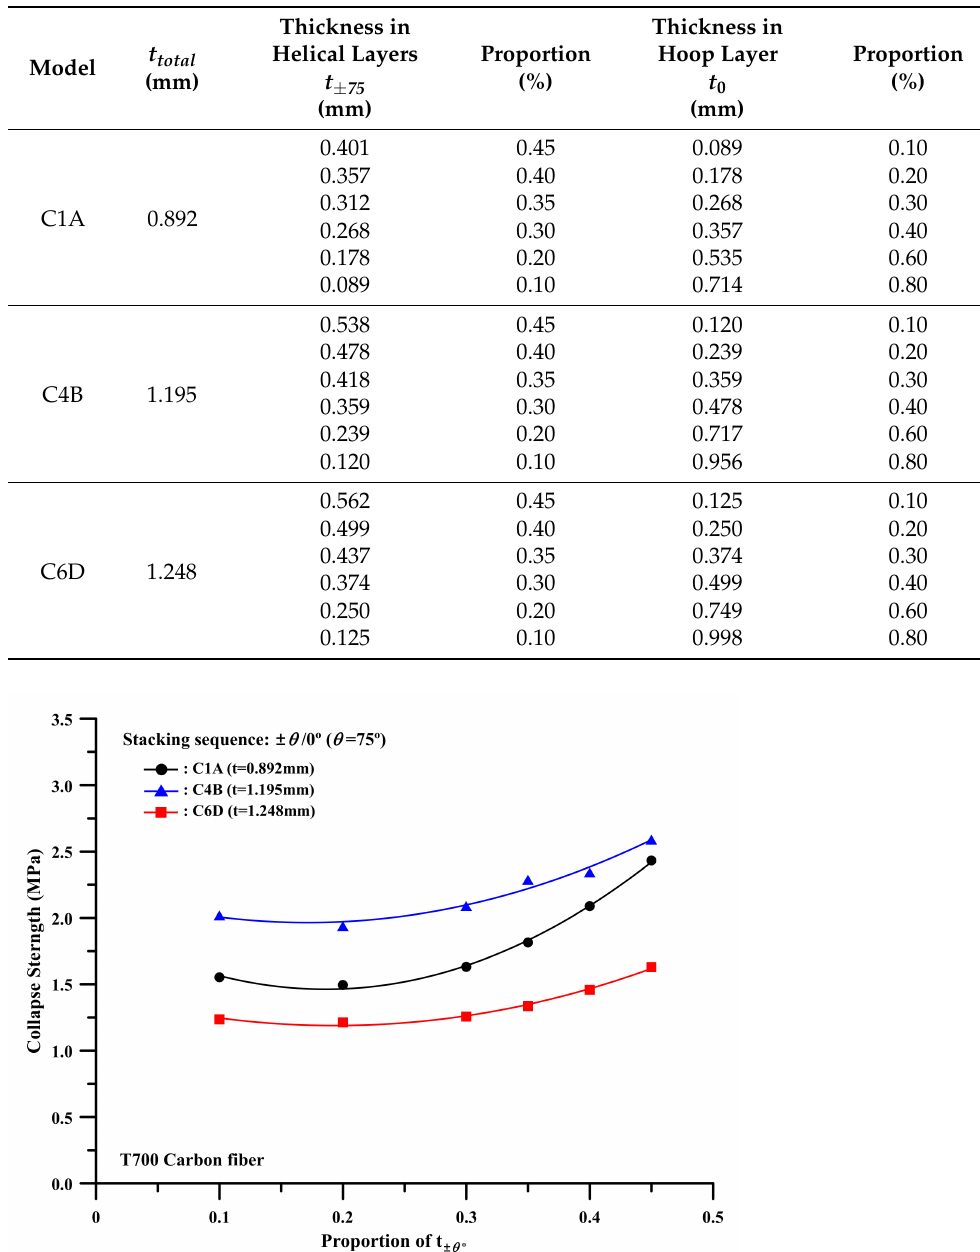
Table 9. Each ply thickness for three lamination stacking sequence.